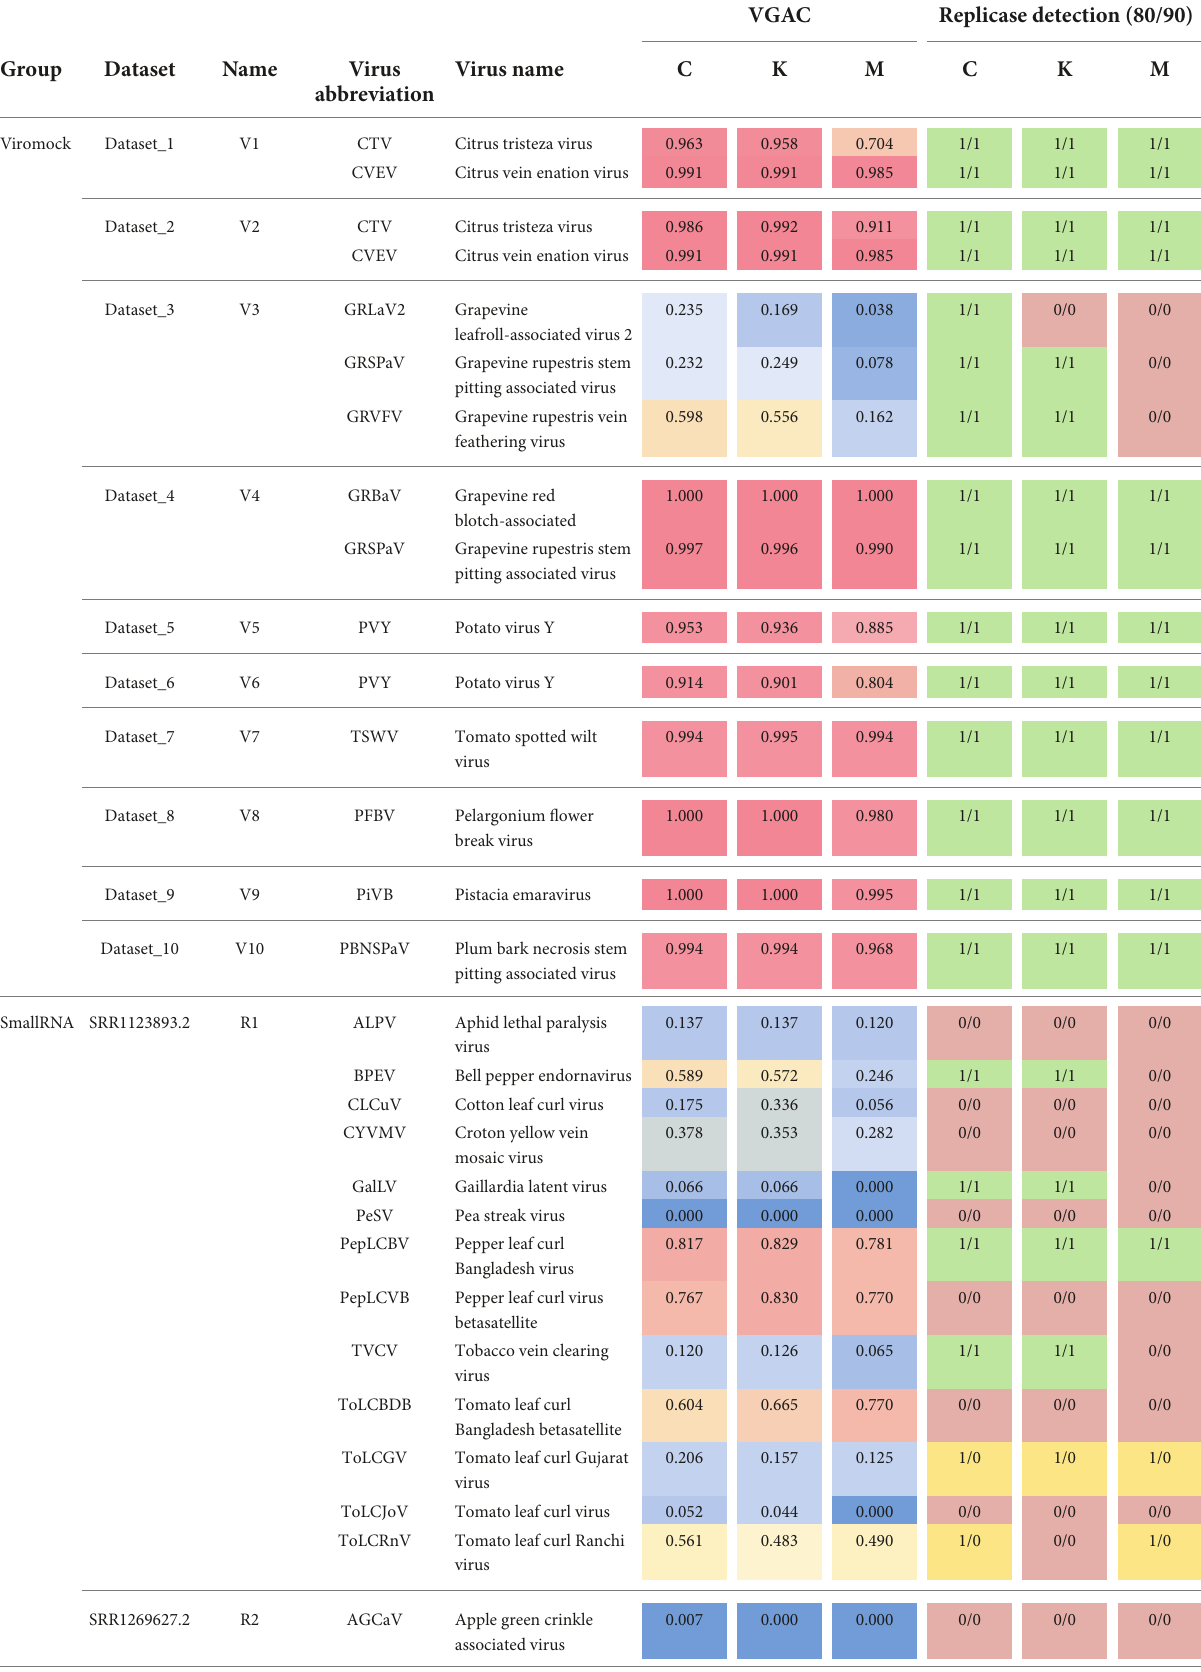
TABLE 1 Summary of performance of pipeline on external datasets.